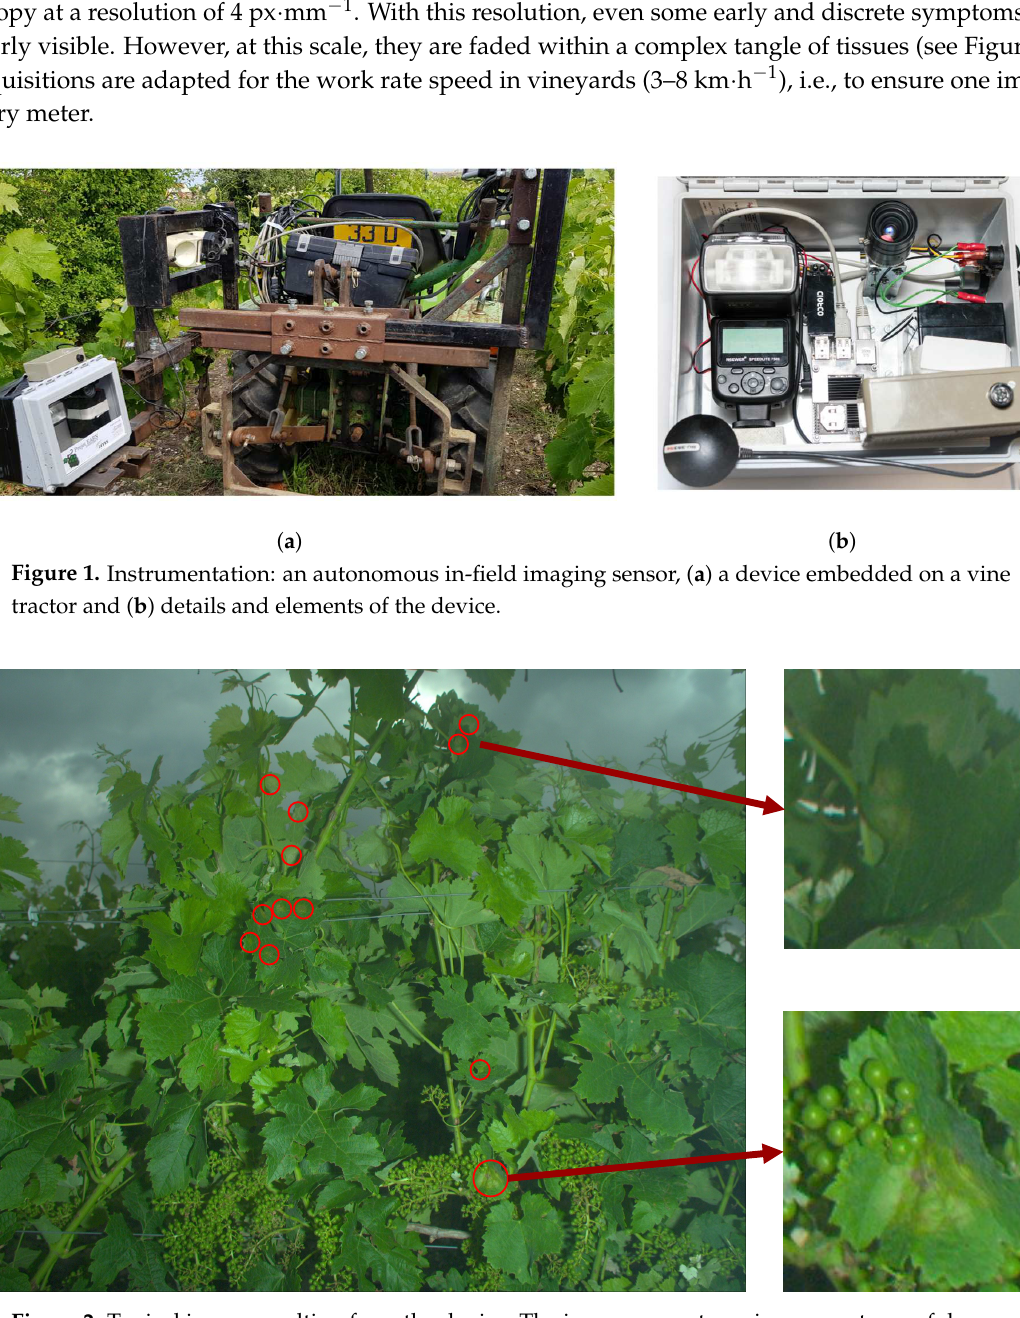
Figure 2. Typical image resulting from the device. The image presents various symptoms of downy mildew circled in red. Two examples of typical “oil spots” are